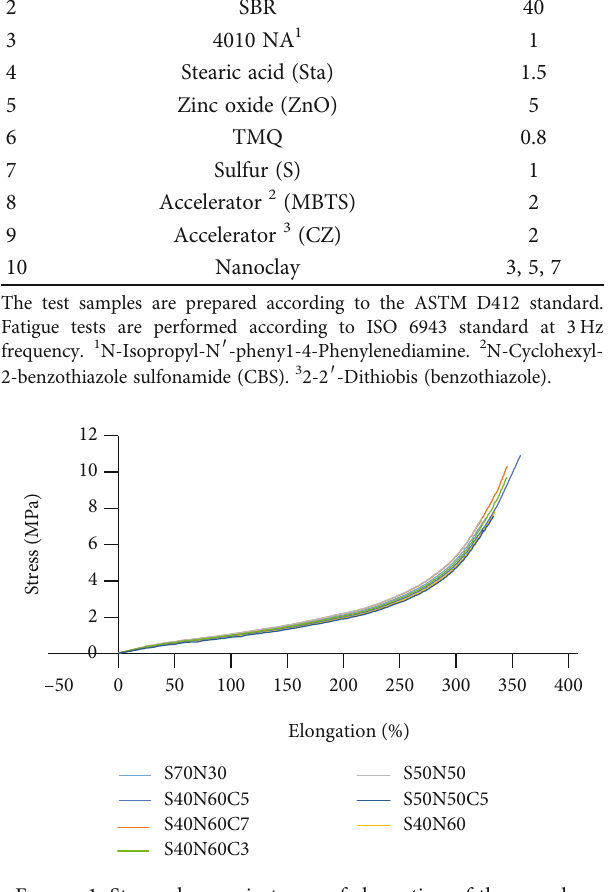
Figure 1: Stress changes in terms of elongation of the